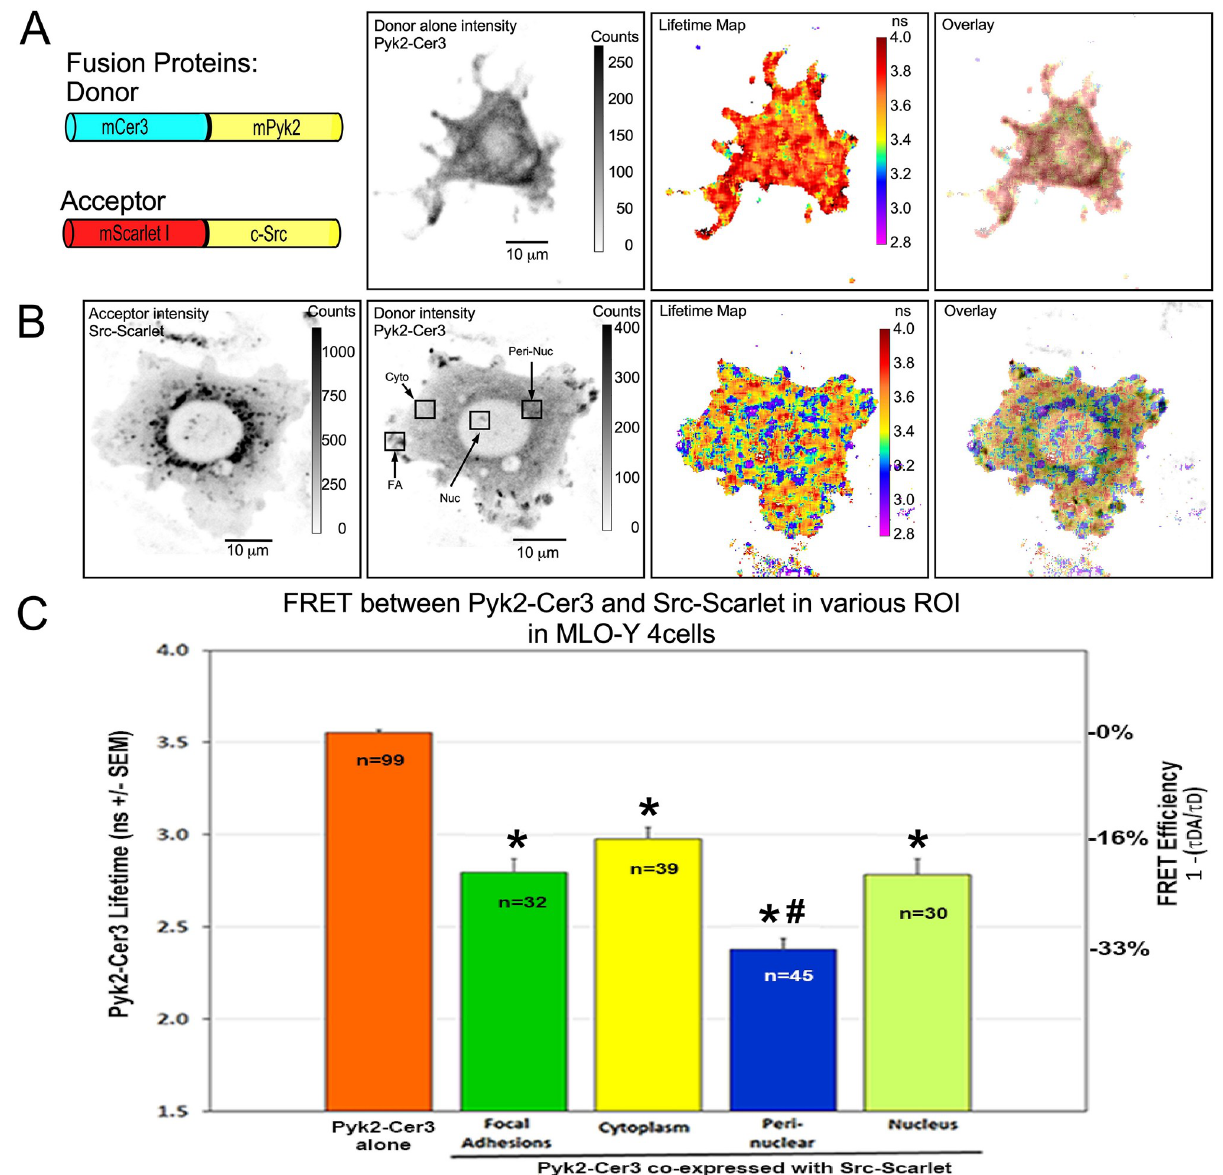
Fig 2. FRET between Pyk2-Cer3 and Src-Scarlet in various ROI in MLO-Y4 cells. Panel A shows (from left to right) diagrams of the Donor (Pyk2-Cer3) and Acceptor (Src-Scarlet) constructs, the intensity distribution of Pyk2-Cer3 donor expressed alone, the Lifetime map of the Pyk2-Cer3 donor alone and the IMD overlay of the Lifetime map and distribution intensity. The lookup table (LUT) indicates pixel-by-pixel lifetime with warmer colors indicating longer lifetime in nanoseconds (ns). Of note, the Lifetime map and IMD overlay in panel A demonstrate the uniform average lifetime (average of 3.56 ns) throughout the cell expressing Pyk2-Cer3 donor alone. Panel B shows cells co-transfected with (from left to right) Src-Scarlet (Acceptor) intensity, Pyk2-Cer3 (Donor) intensity, lifetime map of Pyk2-Cer3 in the presence of Src-Scarlet and the IMD overlay of the Lifetime map and distribution intensity. Here, the cooler colors in the lifetime map and IMD overlay (blues and purples) indicate shorter lifetimes consistent with where FRET is occurring between Pyk2-Cer3 and Src-Scarlet. Panel C shows quantification of the Pyk2-Cer3 Lifetimes (on the left y-axis) when Pyk2-Cer3 was expressed alone (orange bar), and in 4 regions of interest (ROI) from cells co-transfected with Pyk2-Cer3 and Src-Scarlet. Examples of where in cells the ROI were selected are illustrated in the Pyk2-Cer3 donor intensity frame of panel B, including focal adhesions (FA), cytoplasm, peri- nuclear region and inside the nucleus. FRET (on the right y-axis) between Pyk2-Cer3 and Src-Scarlet was detected in all four ROI ( � p < 0.05, compared to Pyk2-Cer3 alone; #p < 0.05 compared to FA, cytoplasm and nucleus by one-way ANOVA on ranks followed by Dunn’s pairwise comparison) and occurred with the highest FRET efficiency in the peri-nuclear